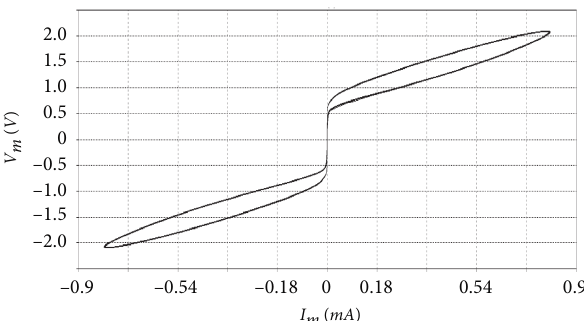
Figure 5: For completeness and comparison, the V - i characteristics obtained through simulation of the measured case (Figure 4).